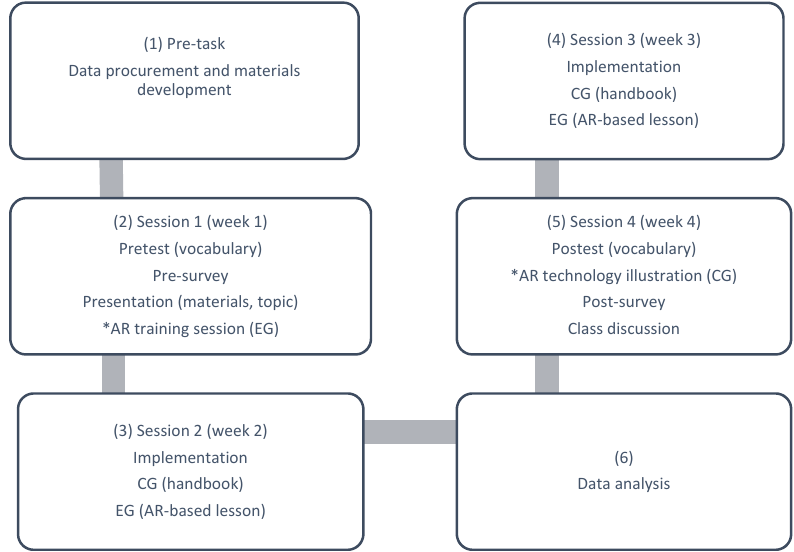
Figure 3. Research stages and procedure .